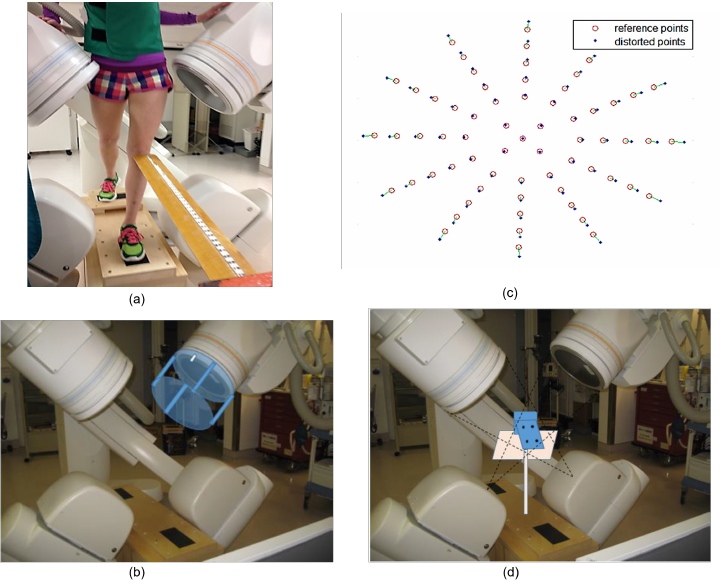
Figure 1. Experimental set-up for fluoroscopic imaging of the knee. ( a ) Bi-plane imaging system. ( b ) Calibration jig made of small stainless steel spheres located at known positions. ( c ) Calibration image. ( d ) An orientation plate was used to determine the common coordinate system between the two